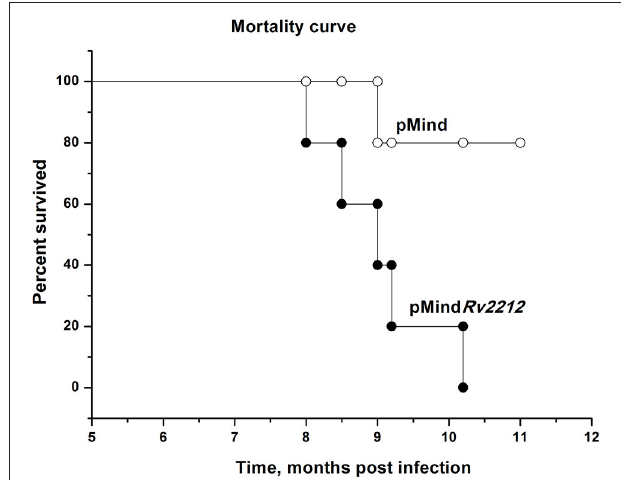
FIGURE 6 | Mortality curve for M. tuberculosis pMind Rv2212- and pMind-infected B6 mice. Mice of B6 inbred strain were infected with 5 × 10 6 CFUs of M. tuberculosis pMind Rv2212 (closed circles) or pMind (open circles). Mortality was monitored